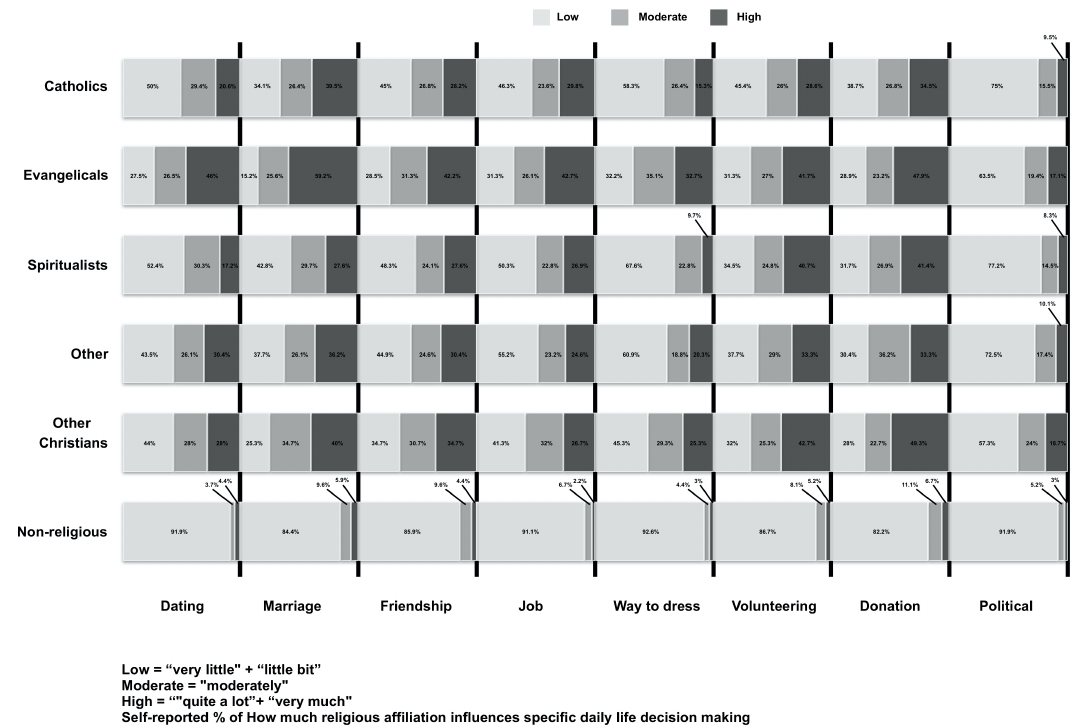
Figure 1. Religious affiliation’s influences in daily